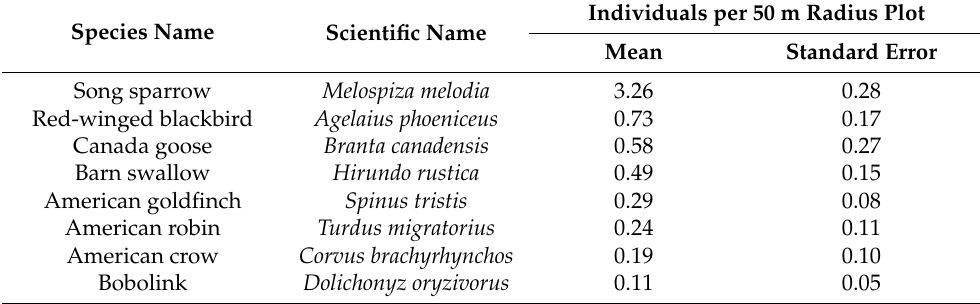
Table 1. Bird species with an average of >0.1 individuals per 50 m radius plot per survey within the Ruby Run riparian area at JW Ruby Research Farm in Preston County, West Virginia, USA, based on monthly point count surveys,